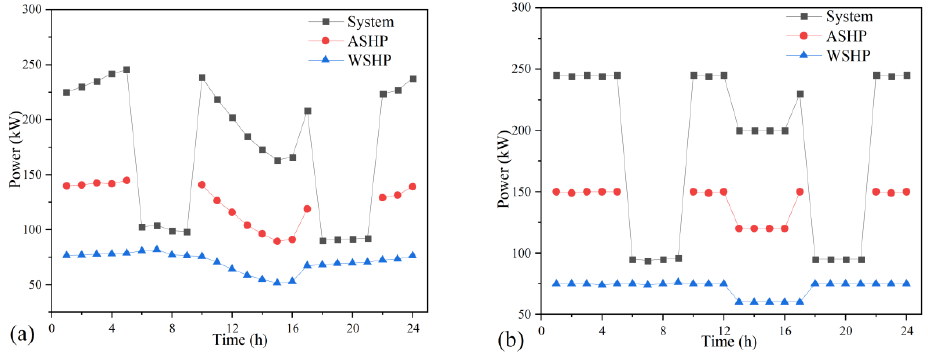
Figure 10. Power of ASHP, WSHP and system. ( a ) simulated, ( b ) tested.